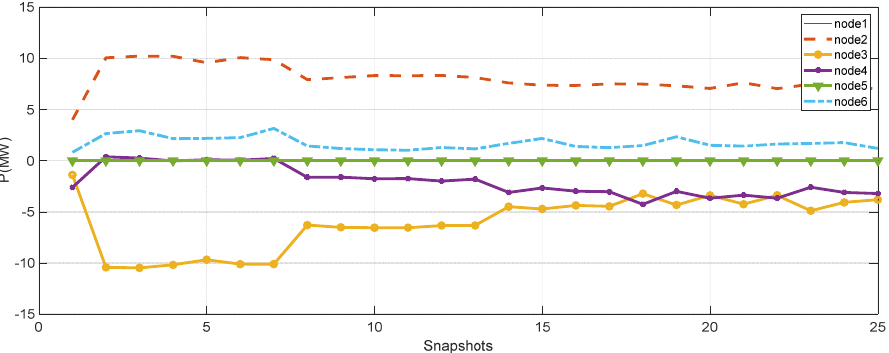
Figure 9. Difference between active powers in two operating states.